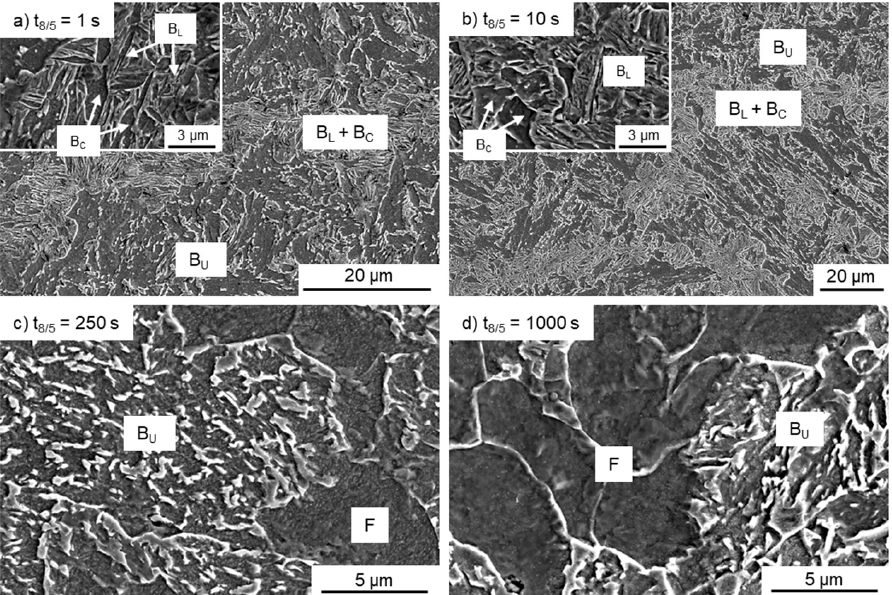
Figure 11. SEM images of the microstructure of the dilatometer specimens heated to 850 °C peak temperature and cooled with different t 8/5 -times of ( a ) 1 s; ( b ) 10 s; ( c ) 250 s; and ( d ) 1000 s showing lower bainite (B L ), coalesced bainite (B C ), upper bainite (B U ) and ferrite (F).